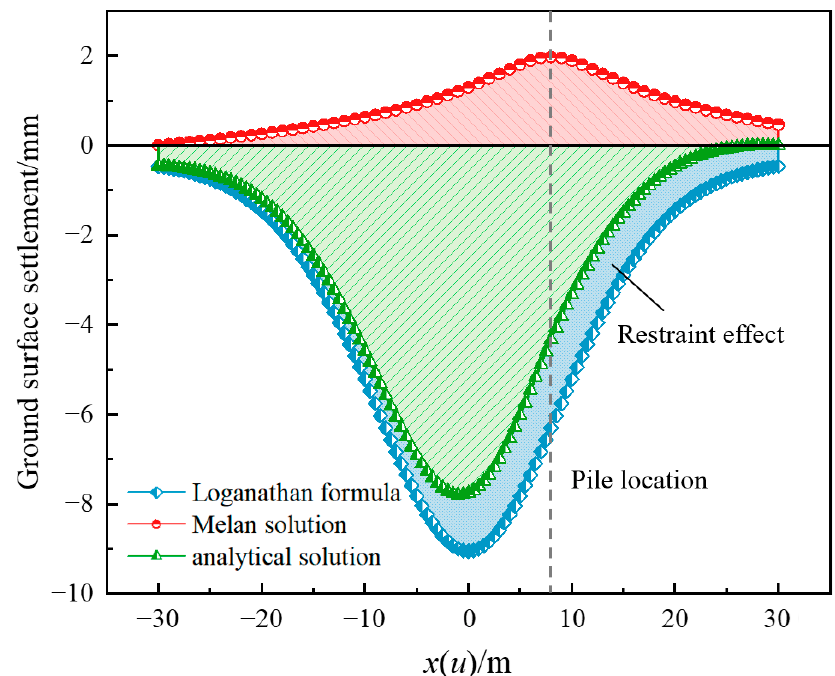
Figure 6. Results of analytical solution.